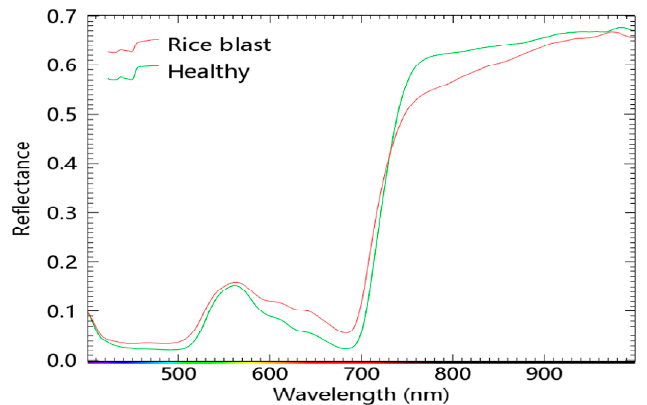
Figure 11. Mean spectral profiles of healthy and diseased rice leaves .